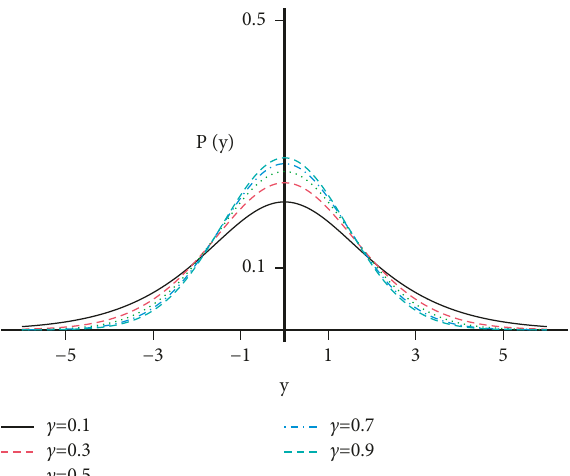
Figure 6: Plots the Bayes rule of with different values of c and; ζ � 0 . 4 , σ 2 � 15 and c � 0 .